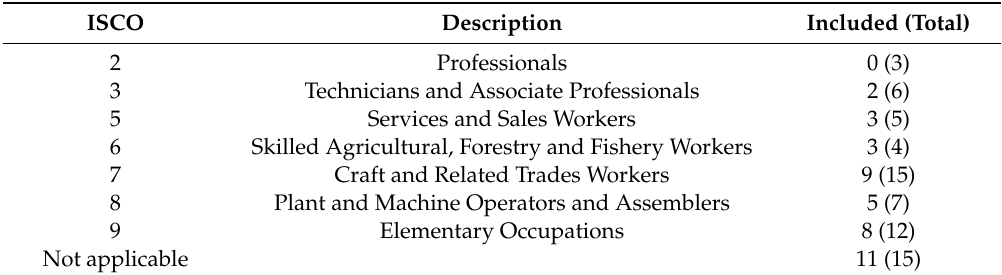
Table 5. Distribution of surveyed cases: economic activity according to ISCO-2008. ISCO Description Included (Total) 2 Professionals 0 (3) 3 Technicians and Associate Professionals 2 (6) 5 Services and Sales Workers Skilled Agricultural, Forestry and Fishery Workers Craft and Related Trades Workers Plant and Machine Operators and Assemblers Not